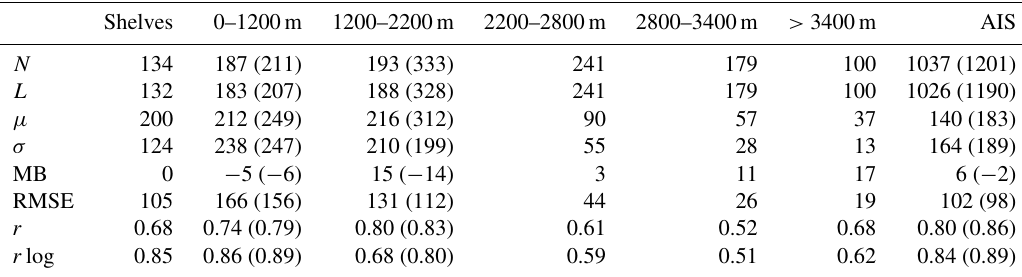
Table 3. A breakdown of GSFC SMB performance against observations separated into different elevation bands to match Mottram et al. (2021) analysis. N is the total number of observations, L is the number used for the logarithmic analysis, µ is the mean of the observations, σ is the standard deviation, MB is the mean bias (model minus observation), RMSE is the root mean square error, r is the correlation coeffi- cient, and r log is the correlation coefficient of the logarithmic values. Values not in parentheses are our best attempt to match the Mottram et al. (2021) model–observation comparison method. Values within the parentheses also include SMB values from Medley et al. (2013), which were excluded from the Mottram et al. (2021)